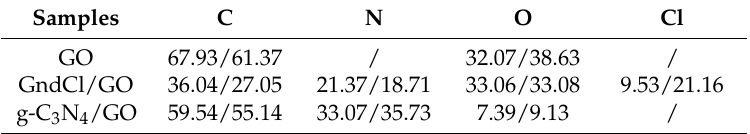
Table 1. C, O and N content (at%/wt %) of the sample according to XPS analysis from Figure 3.